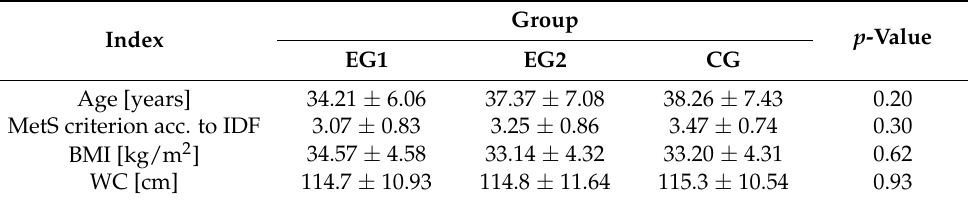
Table 2. Characteristics of the research participants in the aerobic group (EG1), aerobic-resistance group (EG2), and control group (CG).